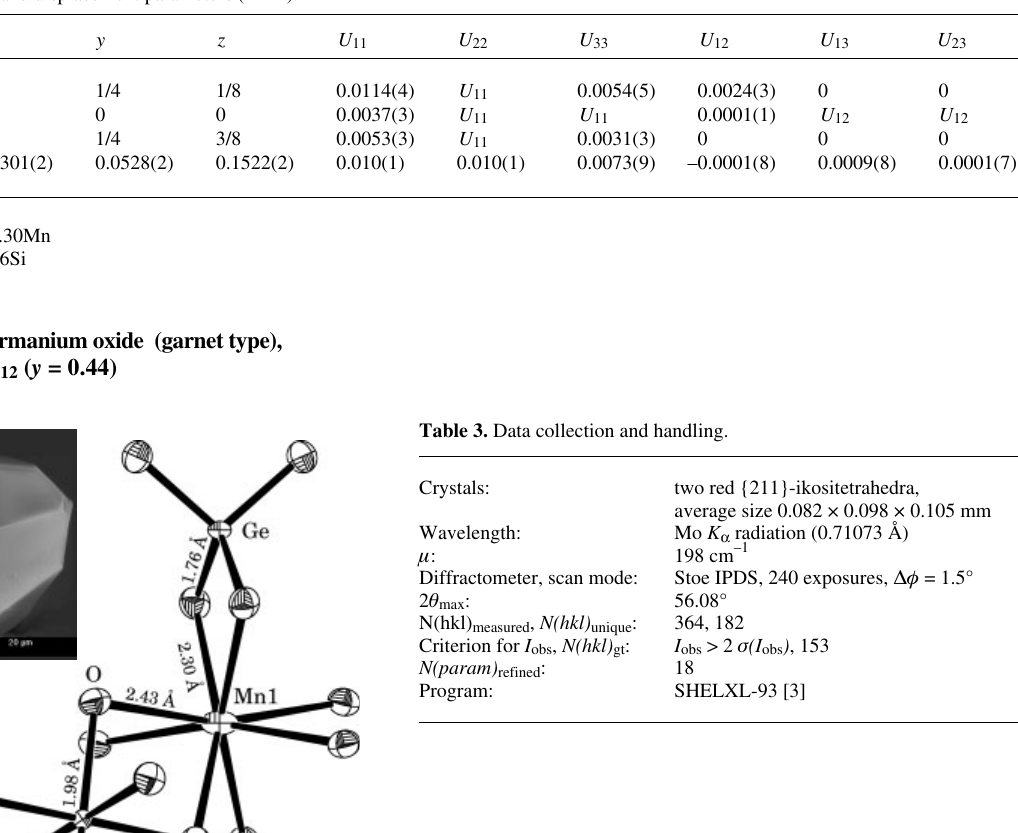
Table 2. Atomic coordinates and displacement parameters (in Å 2 ) .